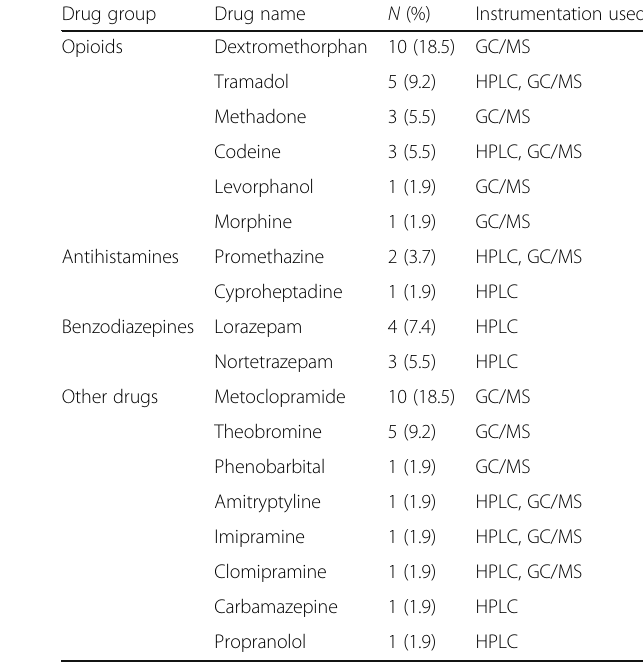
Table 2 Detected drugs in the urine samples of the drug-facilitated crime